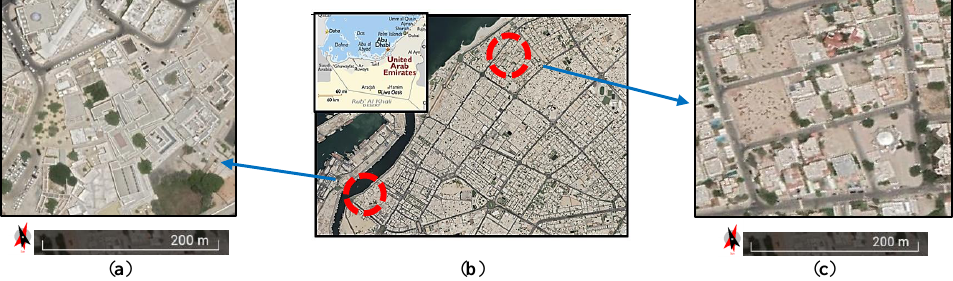
Figure 2. Two cases, old and new. ( a ) — Traditional Al Marijah, heart of Sharjah heritage area [42]. ( b ) — Sharjah, in the United Arab Emirates [42,43]. ( c ) — The modern Sharqan area [42].